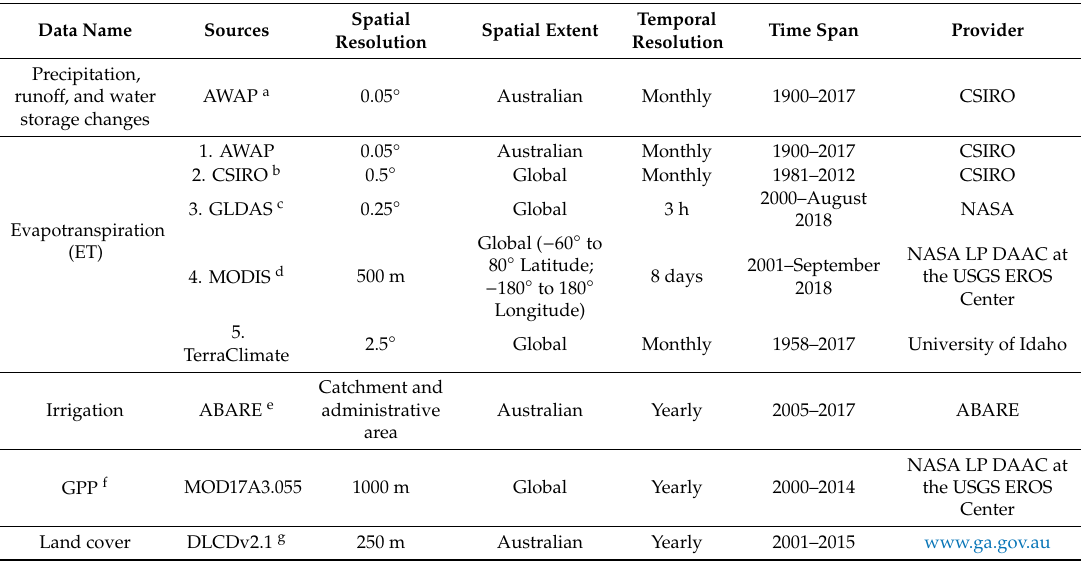
Table 1. The information of data used in this